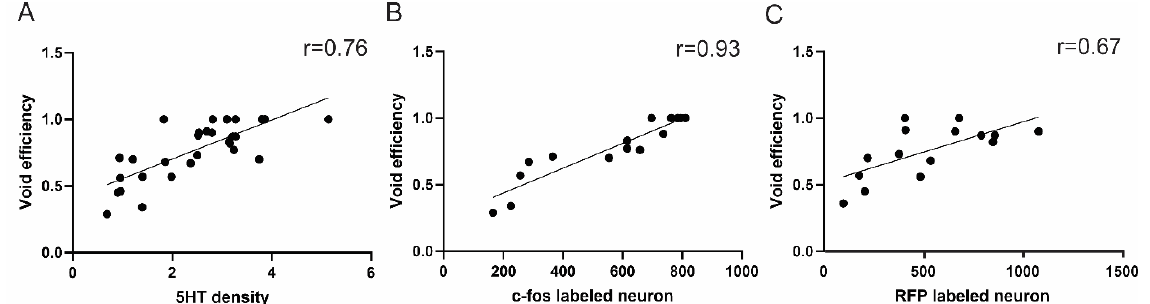
Figure 9. Correlation between supraspinal control and micturition function. There were good correlations between voiding efficiency and ( A ) gray value of 5-HT positive axons, ( B ) number of c-fos positive brainstem neurons, and ( C ) number of RFP-labeled brainstem neurons.